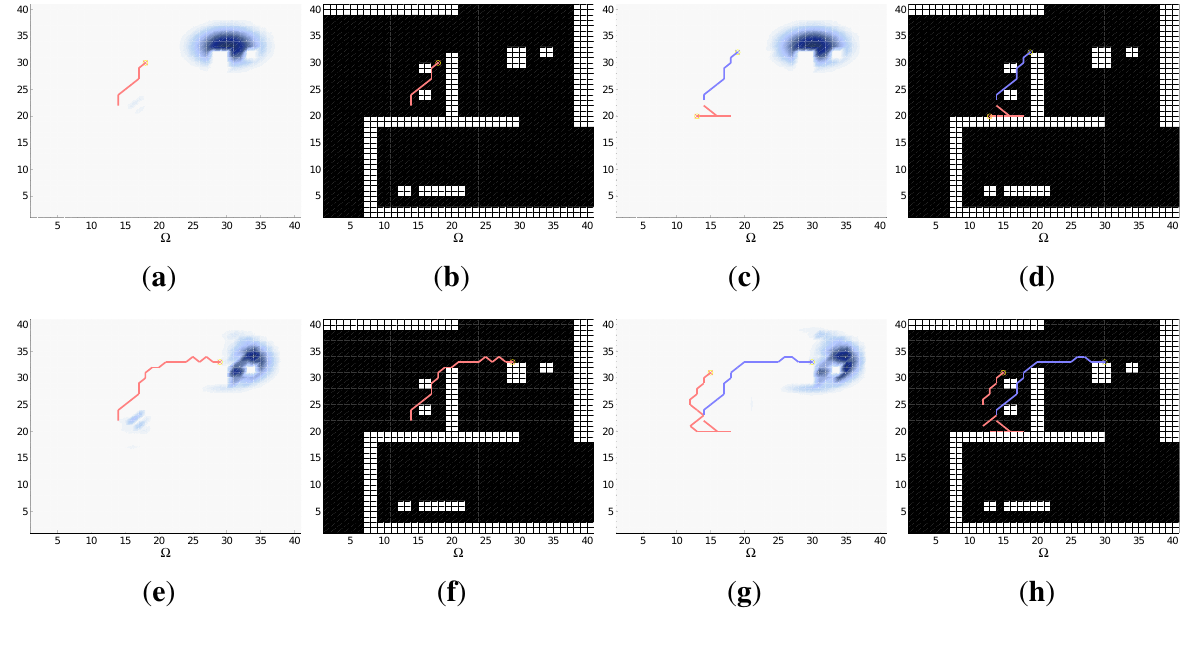
Figure 11. Simulations in the static ultrasonic scanner scenario. ( a ) k = 10 , M = 1 ; ( b ) k = 10 , M = 1 ; ( c ) k = 10 , M = 2 ; ( d ) k = 10 , M = 2 ; ( e ) k = 20 , M = 1 ; ( f ) k = 20 , M = 1 ; ( g ) k = 20 , M = 2 ; ( h ) k = 20 , M = 2